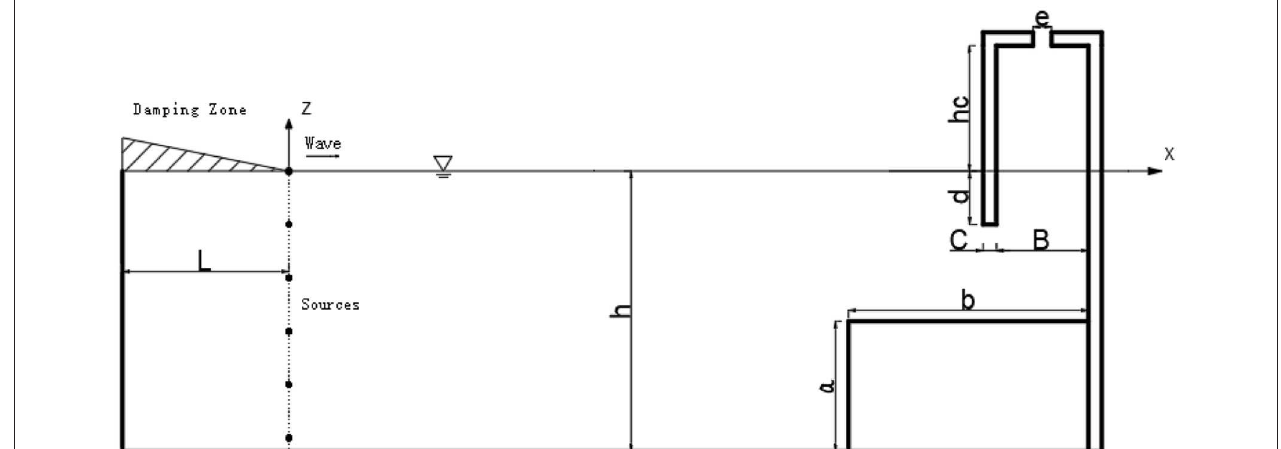
FIGURE 1 | Sketch of the numerical wave